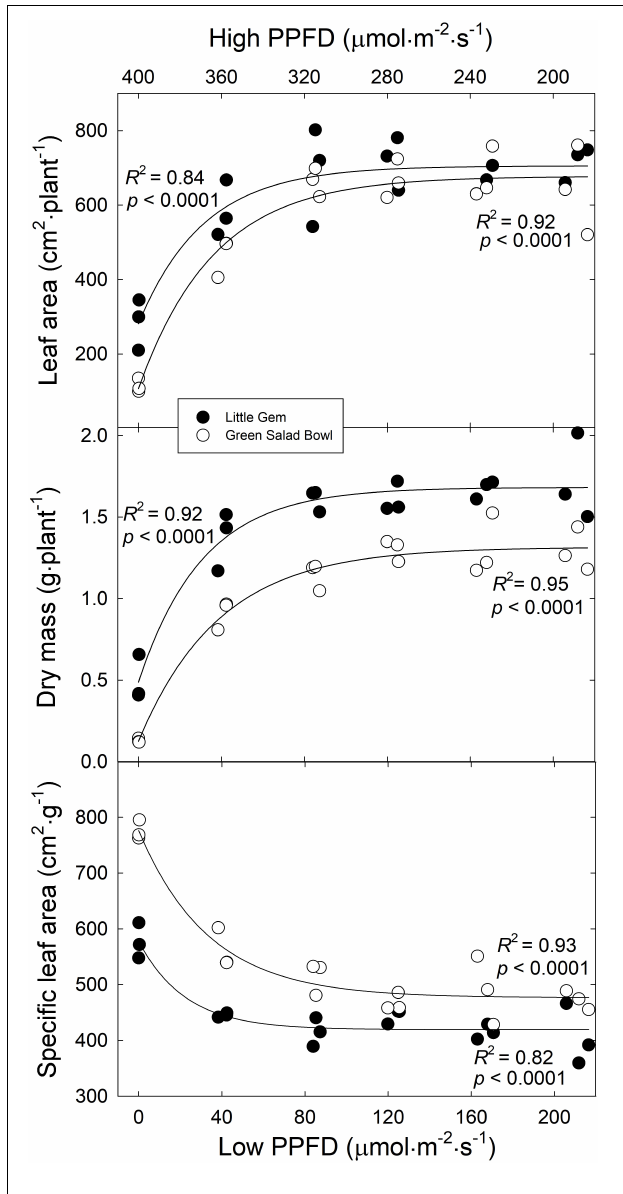
FIGURE 3 | Leaf area per plant, dry mass per plant, and specific leaf area as a function of the treatments ( x -axis indicates lower PPFD). Symbols (three replications per treatment) represent cultivars ‘Green Salad Bowl’ (open symbols) and ‘Little Gem’ (closed symbols) of lettuce ( Lactuca sativa ). Measurements from the three center plants from each tray. Plants were grown under fluctuating photosynthetic photon flux density (PPFD), with PPFD changing every 15 min between high and low intensities ( ∼ 00/0, 360/40, 320/80, 280/120, 240/160, and 200/200 µ mol · m − 2 · s − 1 ).